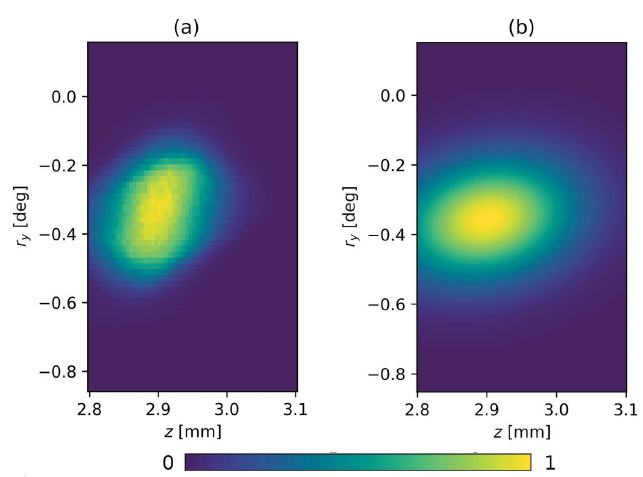
Figure 3 Here we directly compare ( a ) a high-resolution 2D raster scan of the FOM intensity F ( p , M = 2) and ( b ) a Gaussian regressions of a lower- resolution 4D raster scan. Both scans depict a feature-scaled scan over ( z , r y ), fixing the remaining variables at ð y (cid:10) ; r (cid:10)